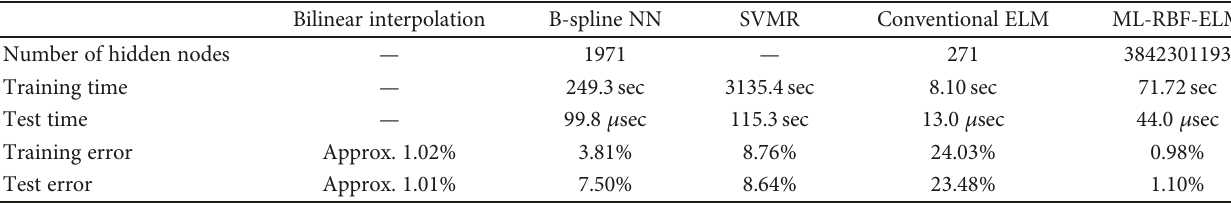
Table 1: Results of various DEM fi tting